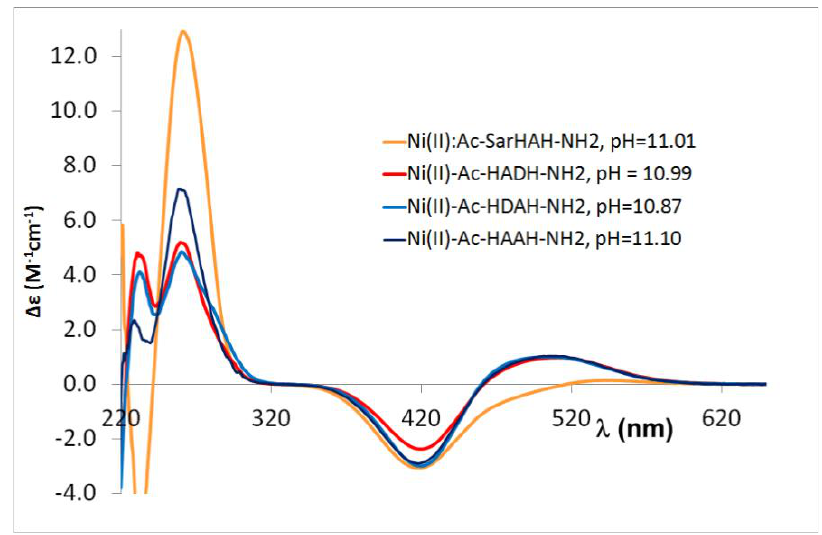
Figure A6. CD spectra registered in equimolar solution of Ni(II)-tetrapeptides solution at pH 11.